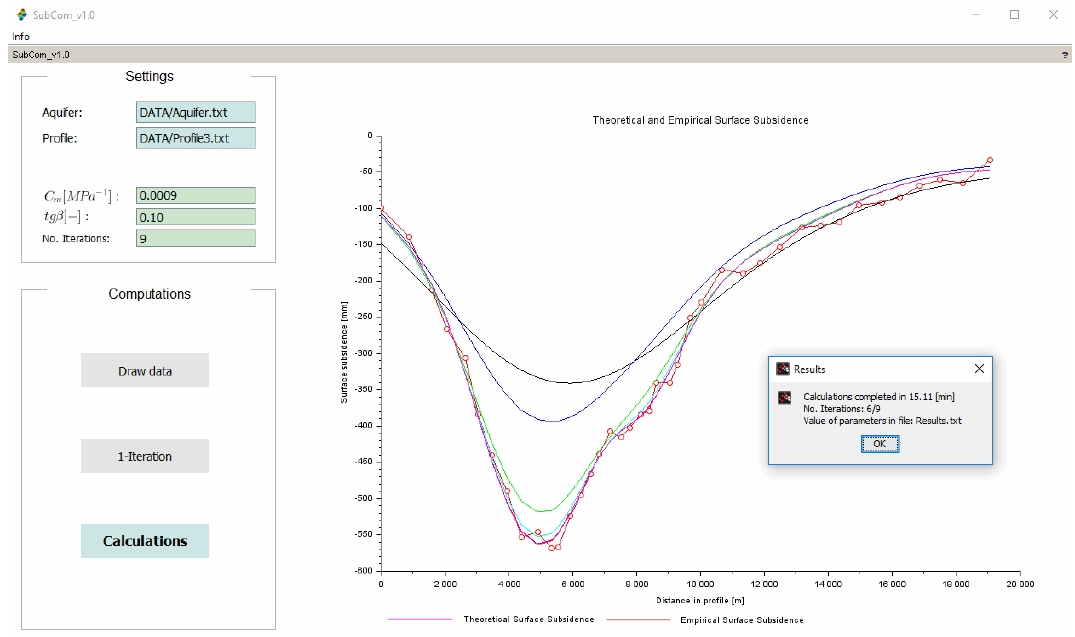
Figure 2. The main window of SubCom v1.0, showing the results of computation.